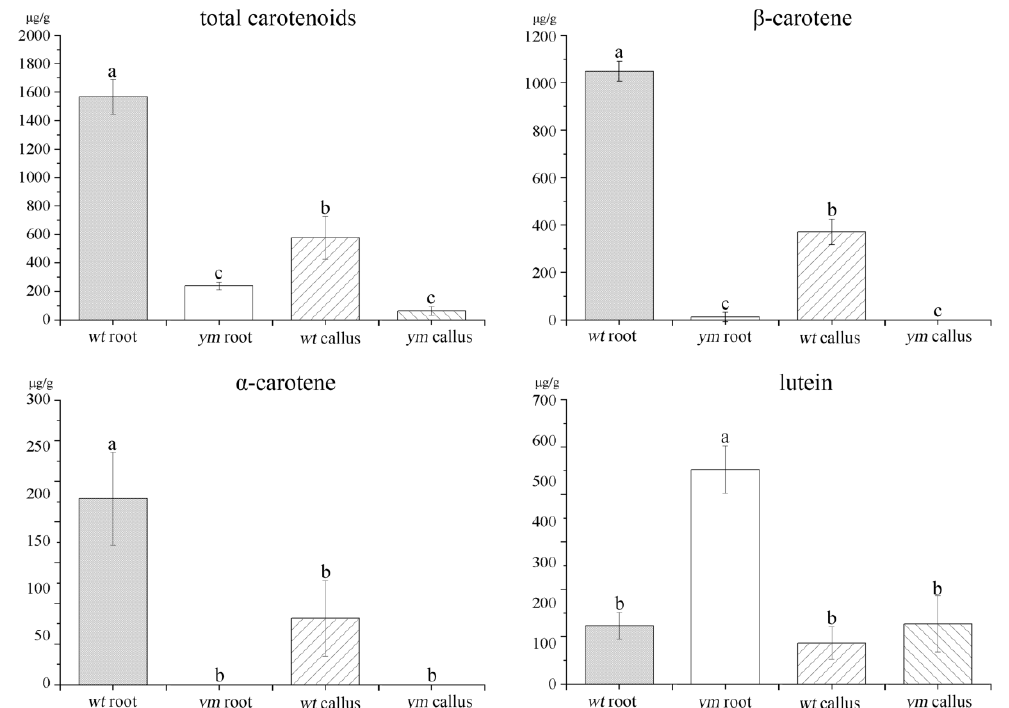
Figure 2. Carotenoid compositions of the root and callus of wt and ym at 55 dap. Means ( ± standard errors) per unit of DW. Lowercase letters a, b and c indicate significant differences at the 0.05 level.